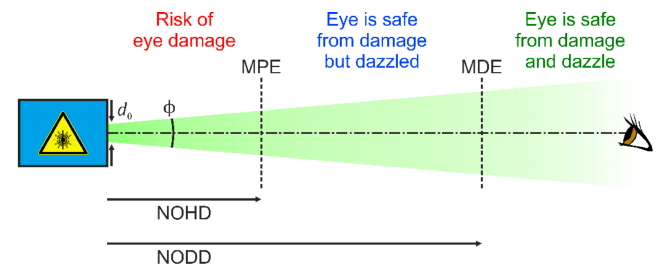
Figure 1. Hazard distances for the human eye: Nominal Ocular Hazard Distance (NOHD) and Nominal Ocular Dazzle Distance (NODD). MPE: Maximum Permissible Exposure; MDE: Maximum Dazzle